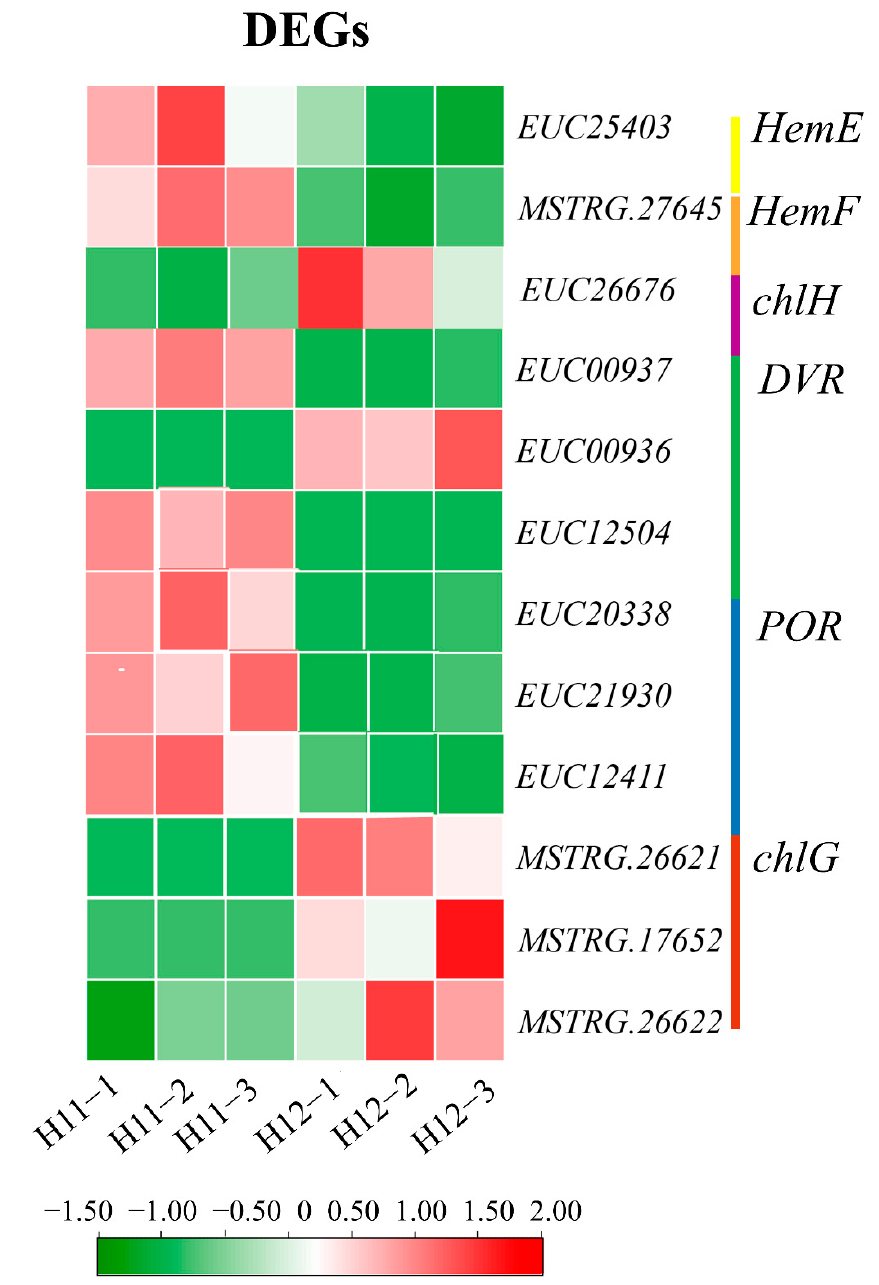
Figure 4. Differential expression of genes related to the chlorophyll metabolism pathway. The gene expression level was based on the FPKM value. The darker the color, the higher the gene expression level.